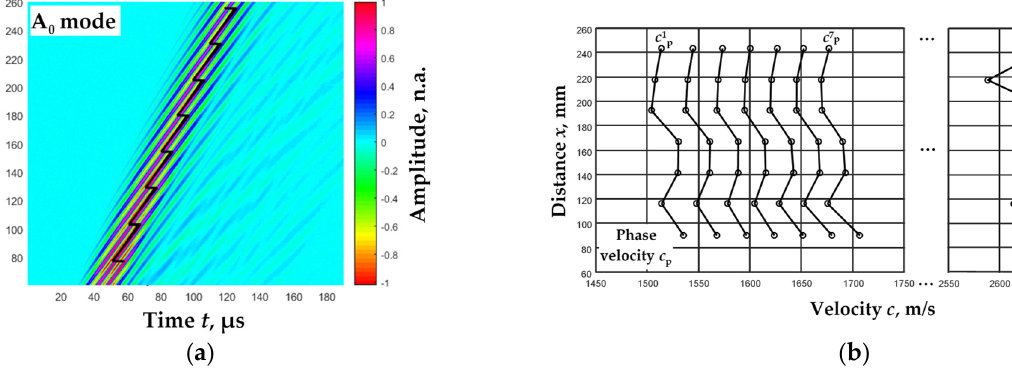
(cid:3036) is the phase (or group) velocity average, q is number of the value of velocity where 𝑐̅ (cid:2926)((cid:2917)) and q = 1, 2, ..., Q, Q is the total number of the velocity values (jump-limited intervals). The calculation results are presented in Table 2. Table 2. The calculations of the velocity averages, the mean absolute errors and the mean relative errors of the phase and group velocities.